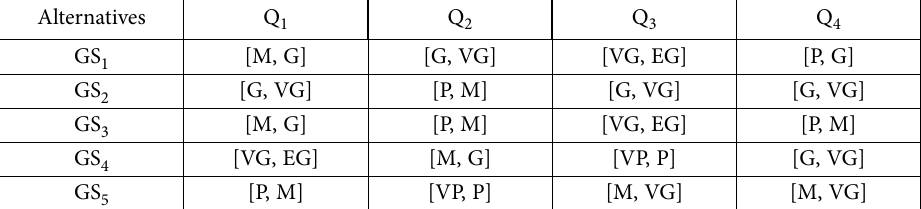
Table 2. The ULTSs through DM 2